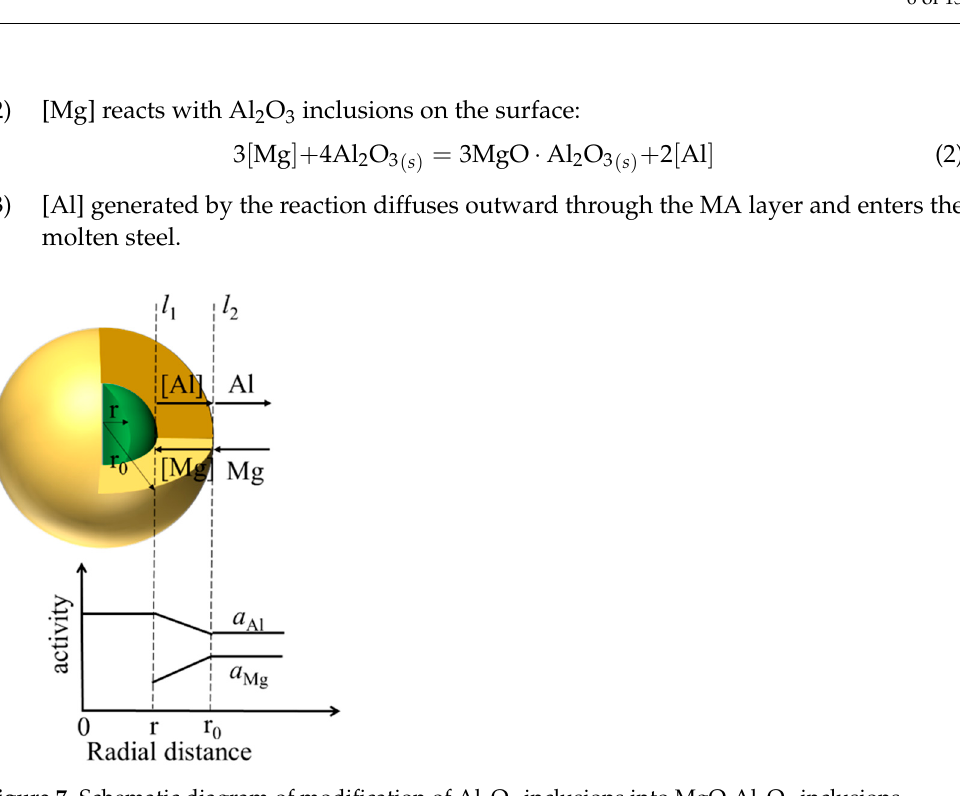
Figure 7. Schematic diagram of modification of Al 2 O 3 inclusions into MgO·Al 2 O 3 inclusions.